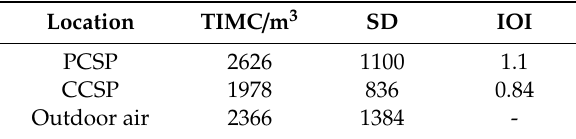
Table 3. TIMC / m 3 and the